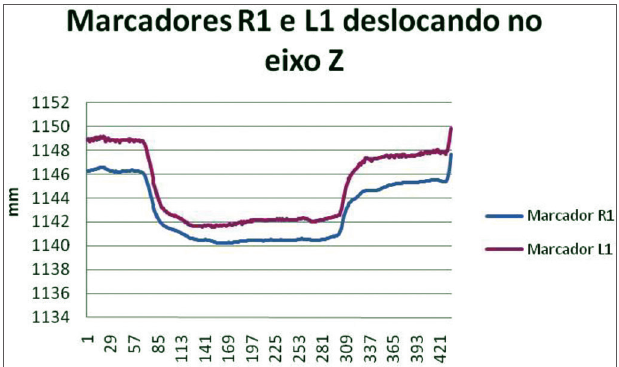
Figura 10. Marcadores R1 e L1 deslocando no eixo Z, franzindo a testa. escolher o método adequado de tratamento, mas tam- bém para avaliar o resultado obtido, além do registro médico legal dos dados desde o primeiro atendimento do paciente até o resultado final do